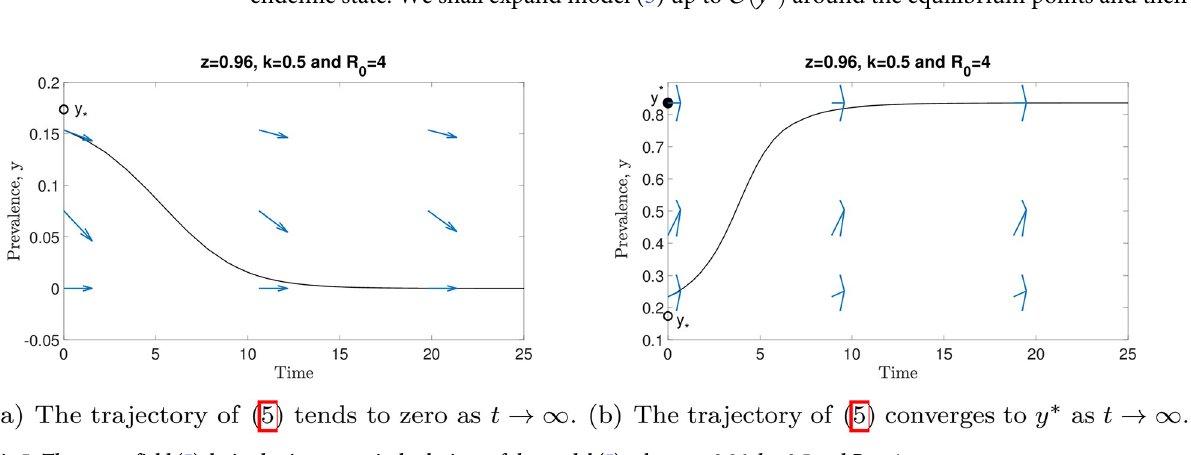
Fig 5. The vector field (5) derived using numerical solutions of the model (5), where z = 0.96, k = 0.5 and R 0 =